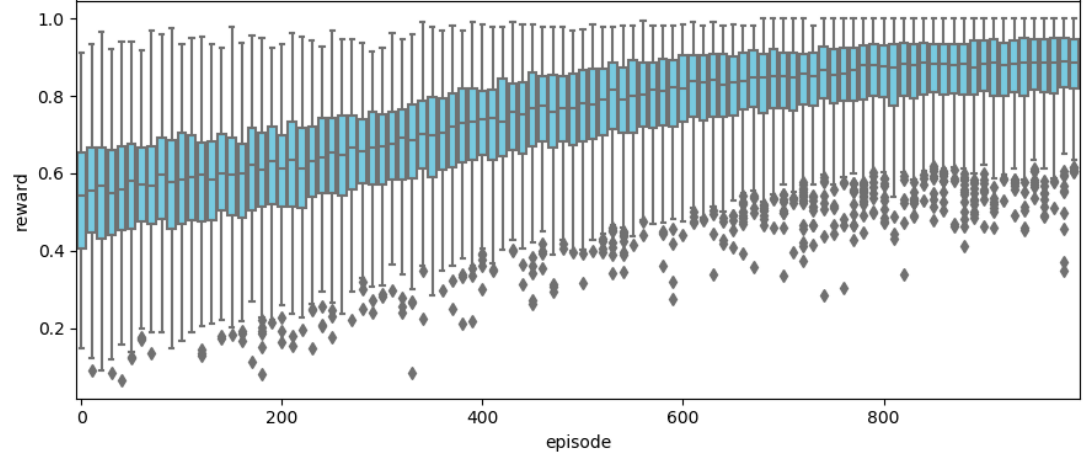
Figure 8. Reward trend curve per episode.